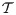
The transformation T in the proof of Theorem 26.